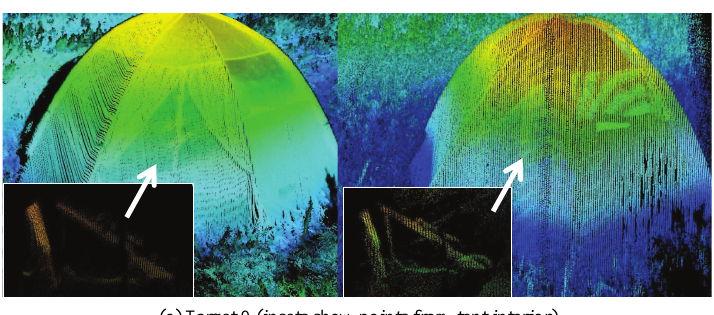
Figure 8: Point clouds of Targets 5 through 9 from top to bottom. VZ-400 and HRS-3D point clouds are on the left and right sides,